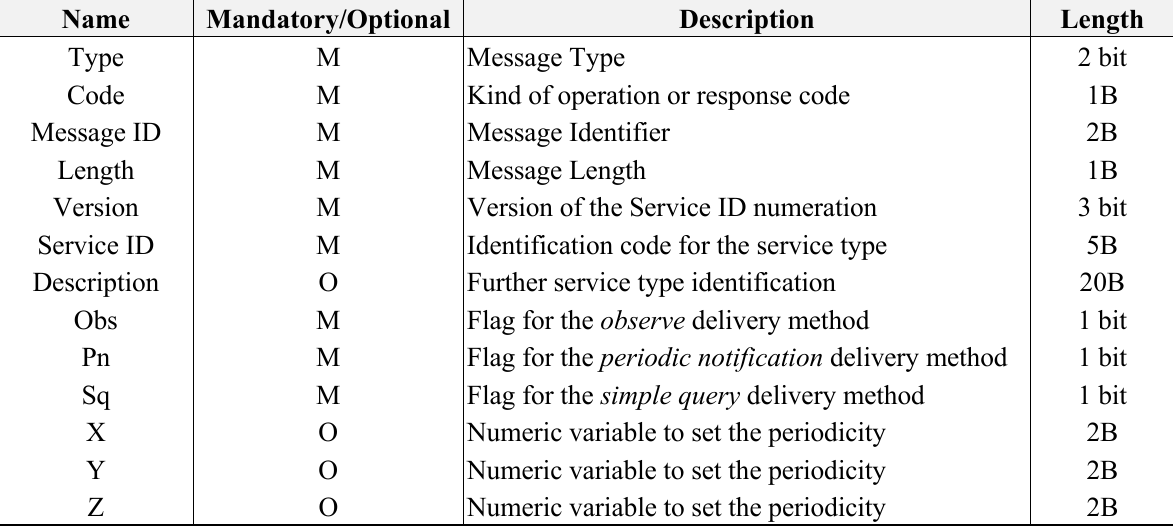
Table 1. Packet fields